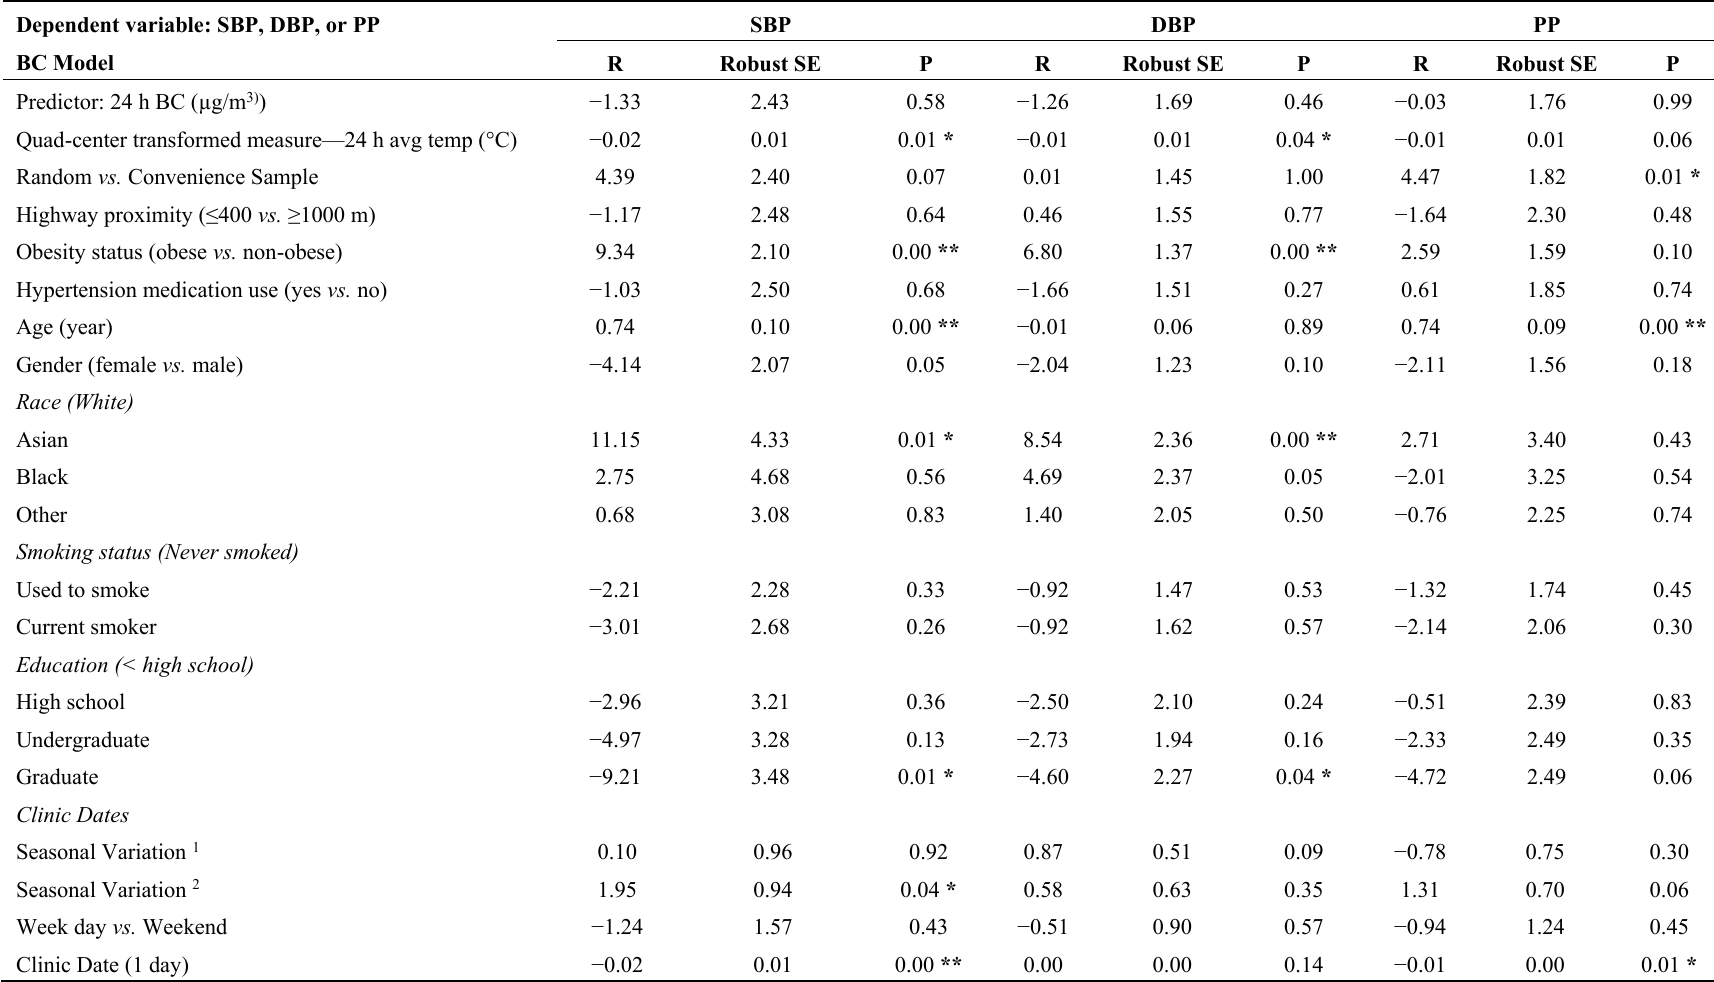
Table 6. Linear Mixed Model of BC (number of observations = 436 in 243